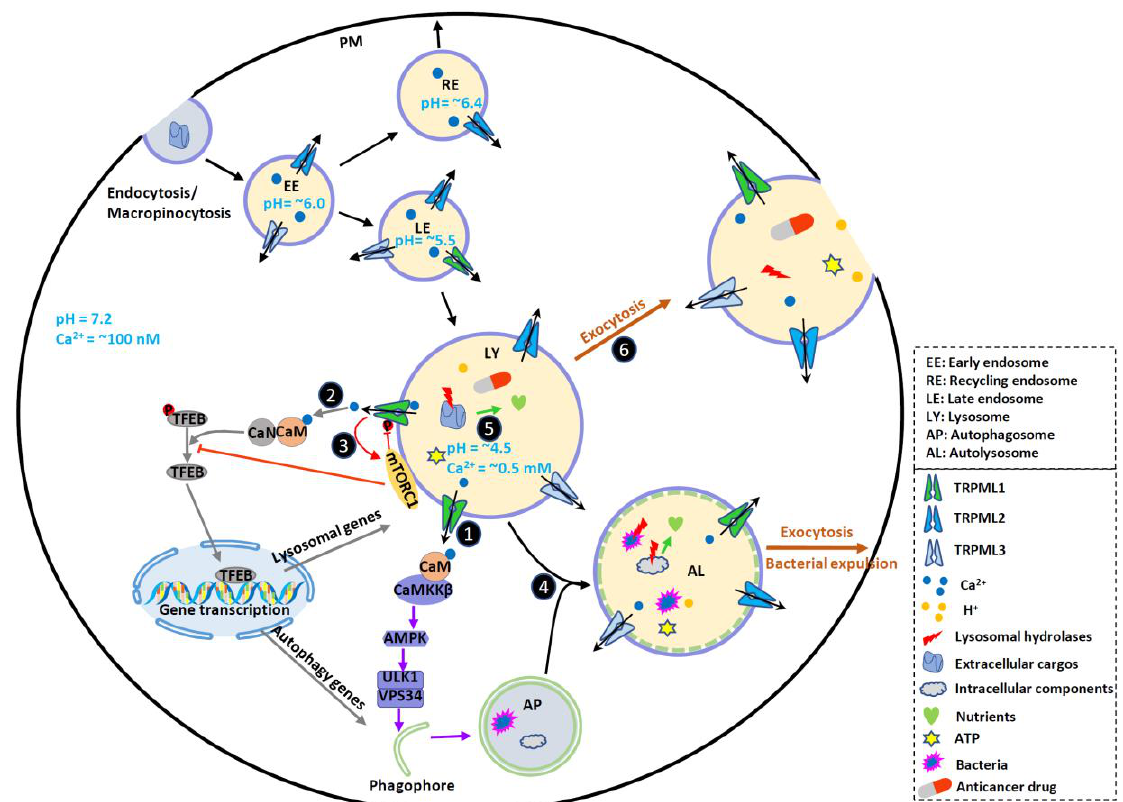
Figure 1. TRPMLs in endocytic, phagocytic and autophagic pathways and tumor progression. TRPMLs are predominately located on the endolysosomal pathway, and they have been involved in endocytic, phagocytic and autophagic pathways. In the tumor microenvironment, autophagy is activated to help cancer cells digest damaged or nonessential proteins and organelles, meeting the increased energy and nutrient demand of cancer cells. By releasing intraluminal Ca 2+ , TRPMLs have been implicated in intracellular Ca 2+ signaling, endolysosome trafficking, and lysosomal functions, further regulating autophagy. First, TRPML1 activates calmodulin (CaM)/CaMKKβ/AMPK pathway to promote autophagosome formation. Second, TRPML1 activates CaM/CaN/TFEB pathway to continuously supply lysosome and autophagy proteins. Third, TRPML1 maintains mTORC1 activity to prevent cancer cell death and promote lysosome reformation. In normal fed conditions, mTORC1 phosphorylates TRPML1 at S571 and S576 to inhibit its activity. Starvation reduces mTORC1 activity and disinhibits TRPML1. This subsequently promotes mTORC1 activity, preventing cell death. Fourth, TRPML1 stimulates Apoptosis-linked gene-2 (ALG-2)-dependent lysosome centripetal movement to facilitate autophagosome-lysosome fusion. Fifth, TRPML1 increases lysosomal degradative functions, likely through controlling lysosomal pH. Sixth, TRPML1 increases Syt7-dependent lysosomal exocytosis, releasing hydrolases, ATP and H + to extracellular spaces. These may change tumor microenvironment, promote ECM degradation, and facilitate tumor progression. By promoting lysosomal exocytosis, TRPML1 may also participate in drug resistance by releasing sequestrated anticancer drugs. Due to the functional redundancy between the TRPML proteins, TRPML2 and TRPML3 may also contribute to some of these events to regulate cancer development. Therefore, TRPMLs orchestrate all these cellular events to help cancer cells maintain high autophagic flux and adapt to the tumor microenvironment.